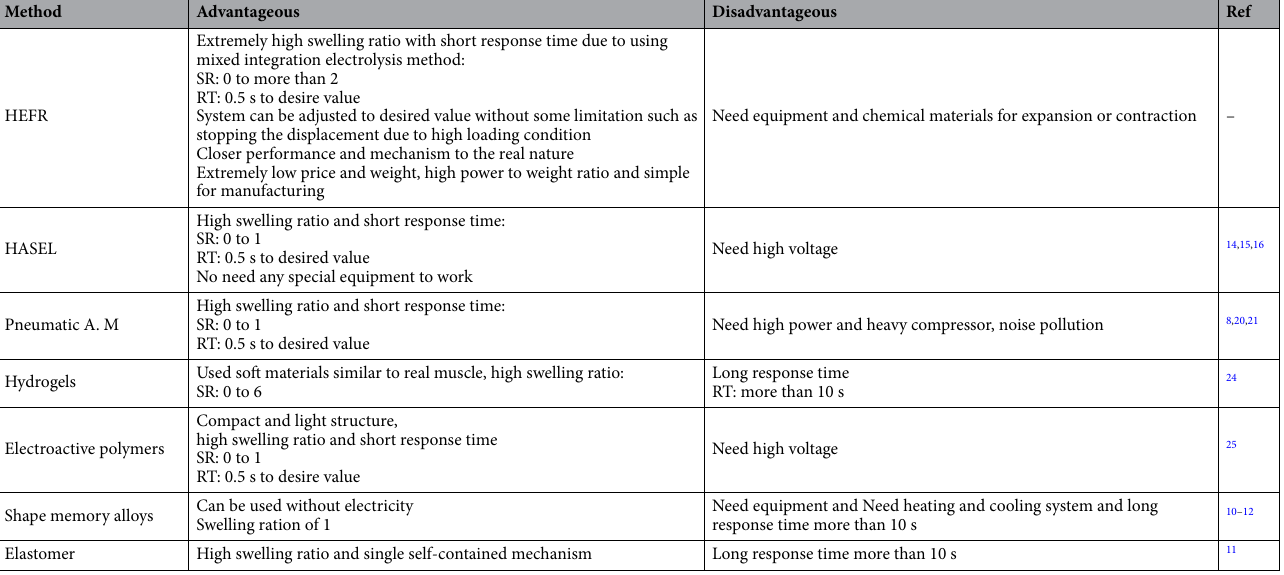
Table 2. Comparison of hybrid Mixed integration electrolyze module and fluid chemical reaction (HEFR) with other